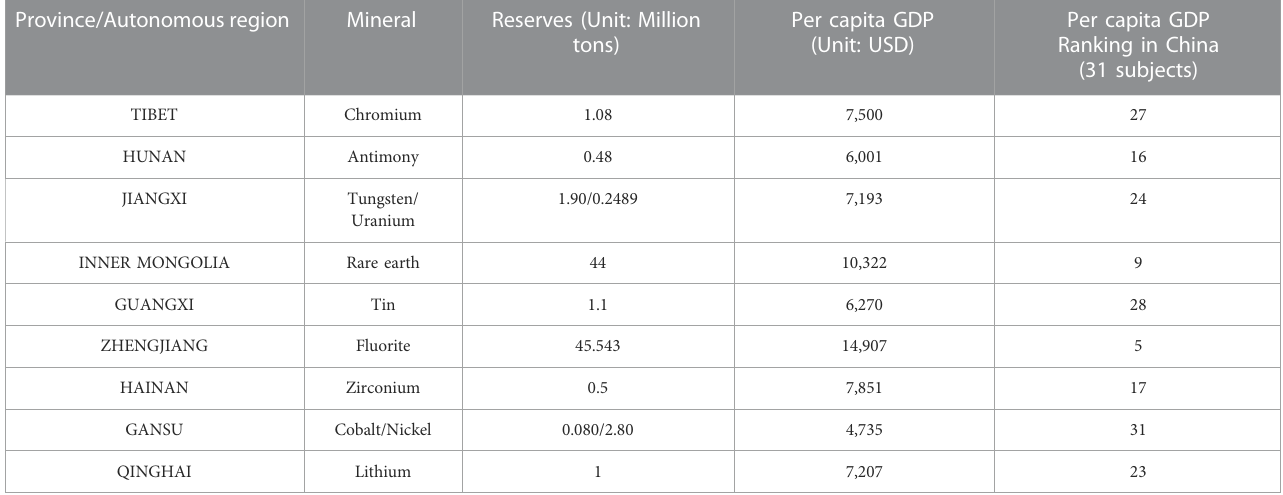
TABLE 1 Mineral reserves, per capita GDP and ranking of major mineral provinces/autonomous region. Province/Autonomous region Mineral Reserves (Unit: Million